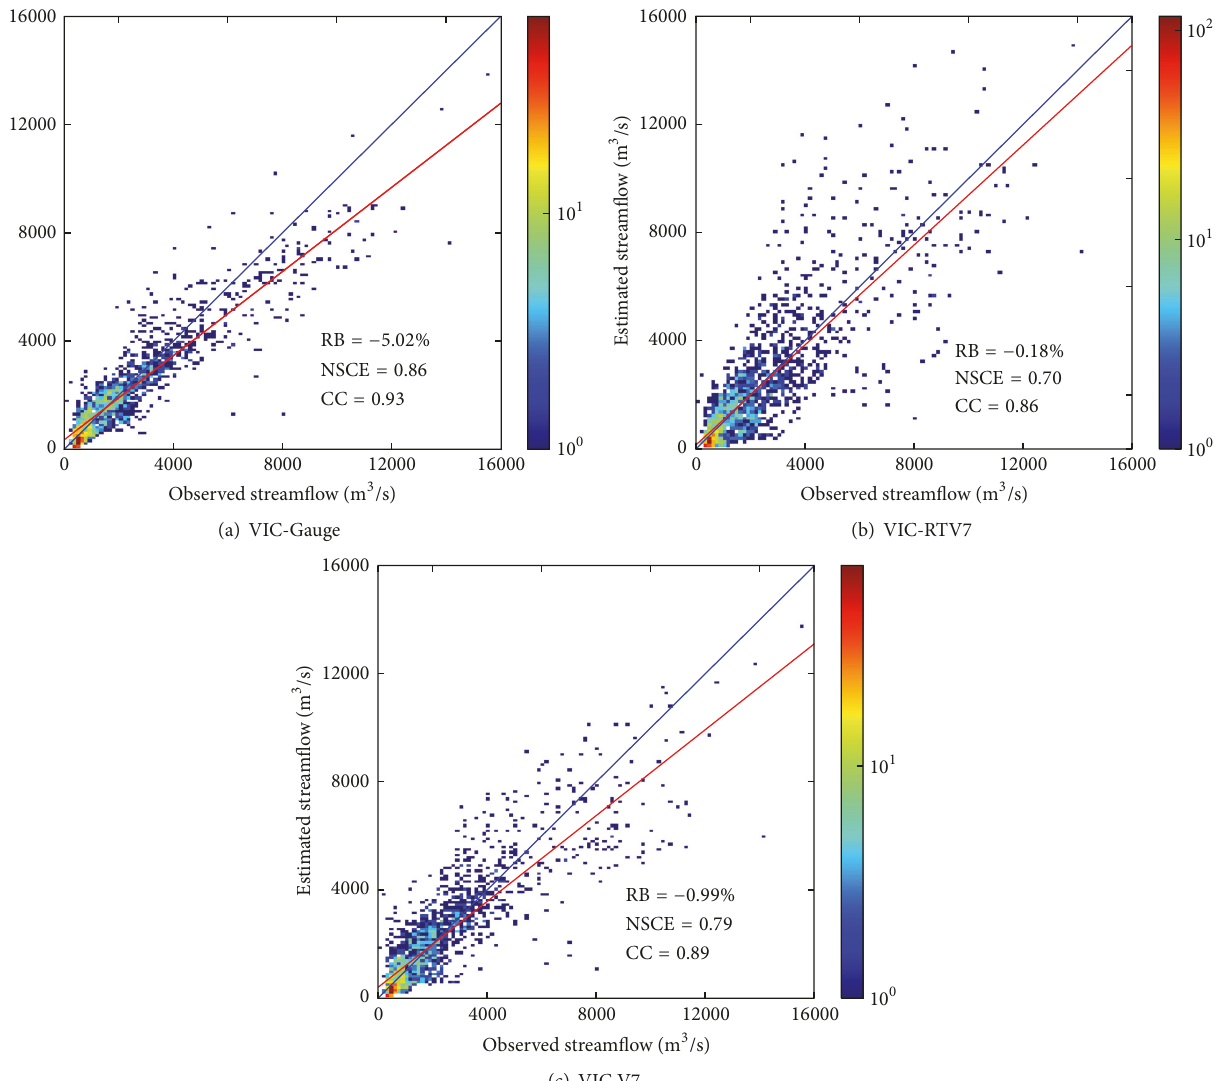
Figure 6: Scatter plots of the observed and simulated streamflow by using VIC hydrological model in the Ganjiang River basin.